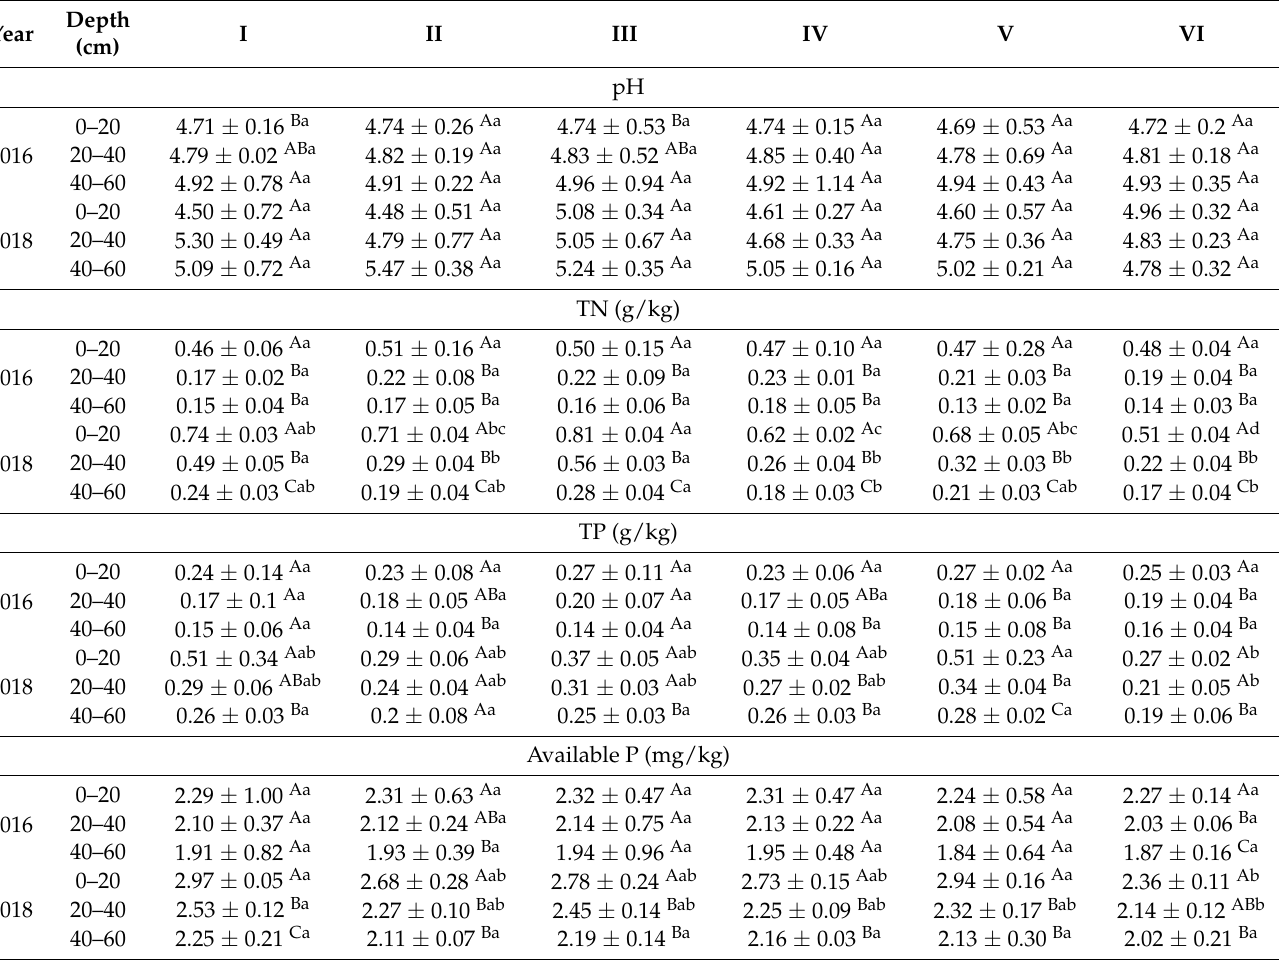
Table 3. Description of the soil’s chemical properties under six forest stands at 0–20, 20–40, and 40–60 cm (mean ± stand error, n =